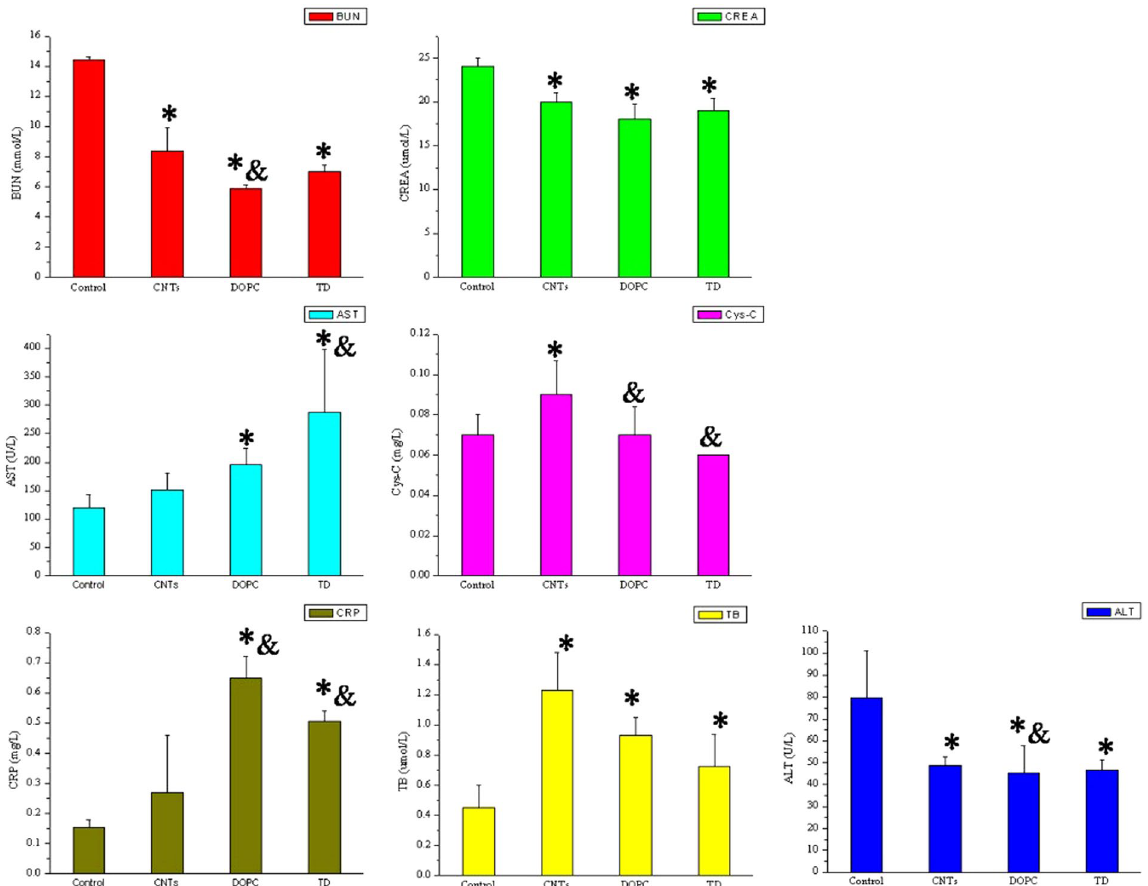
Figure 6. The biochemical indices level of BUN (blood urea nitrogen), CREA (creatinine), AST (aspartate aminotransferase), Cys-C (cystatin C), ALT (alanine aminotransferase), CRP (C-reaction protein) and TB (total bilirubin) change in plasma after exposure oMWCNTs to DOPC/or TD –model mice ( * p < 0.05 for groups vs . control group; & p < 0.05 for groups vs. single oMWCNTs group; n = 5, +